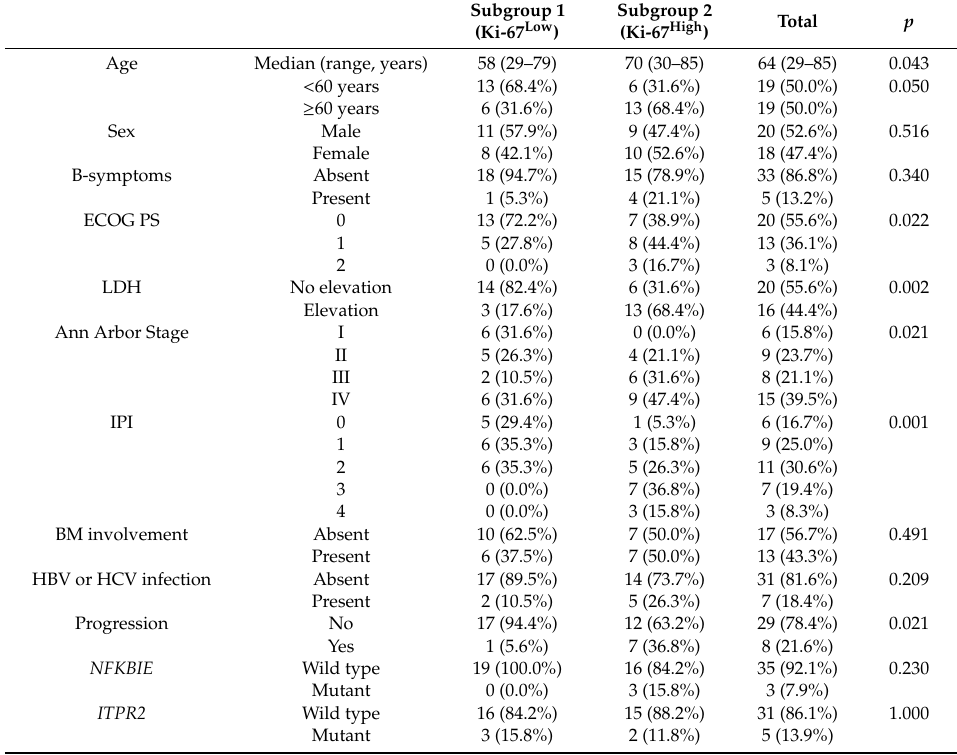
Clinicopathological characteristics according to subgroup determined by the Ki-67 proliferation